Question: Which visualization type does this figure use?
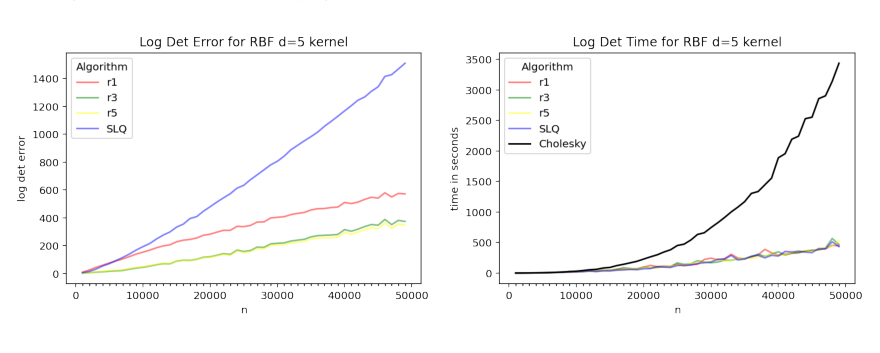
Answer: line